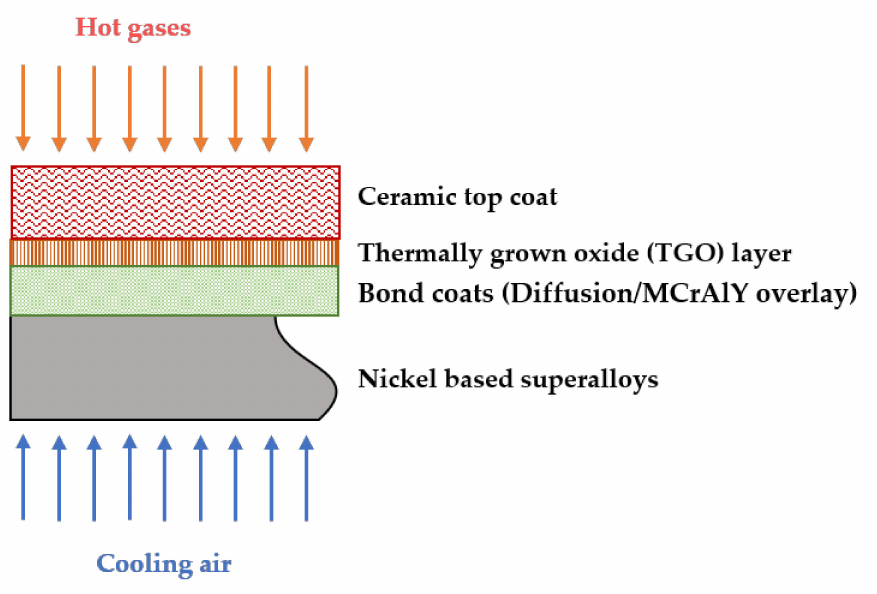
Figure 1. Figure showing the model representation of a TBC